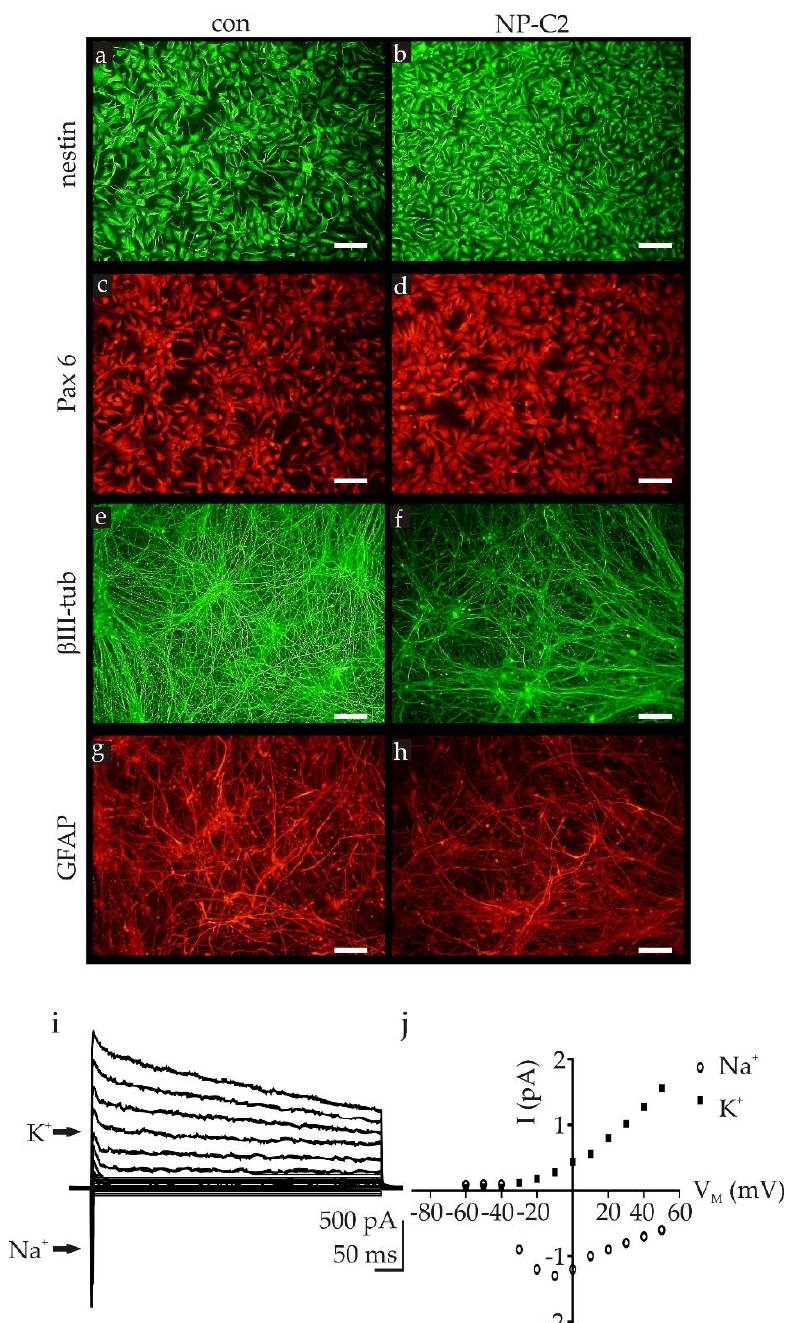
Figure 1. Neuronal differentiation of induced pluripotent stem cells (iPSCs). Neural progenitor cells derived from iPSCs, expressed the progenitor cell markers nestin ( a , b ) and Pax6 ( c , d ), proven by immunocytochemical staining. Neural progenitor cells (NPCs) were terminally differentiated into cultures, containing neurons and glia cells, demonstrated by immunocytochemical staining for the neuronal marker βIII-tubulin ( e , f , green) and the glia cell marker GFAP ( g , h , red). Neurons expressed voltage-activated Na + - and K + -channels, demonstrated by patch clamp recordings of visually identified neurons. Patch clamp measurements revealed typical inward directed Na + - and outward directed K + -currents ( i ), indicated by arrows) and ( j ) current–voltage relationship of observed Na + - and K + -currents shown in ( i ). con = control cell line; NP-C2 = NPC2-deficient cell line; Na + = Na + -currents; K + = K + -currents. Scale bars in a–h = 100 µm.